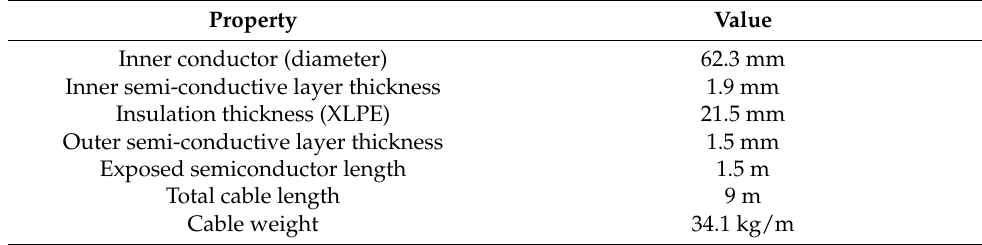
Table 1. HVDC cable properties.